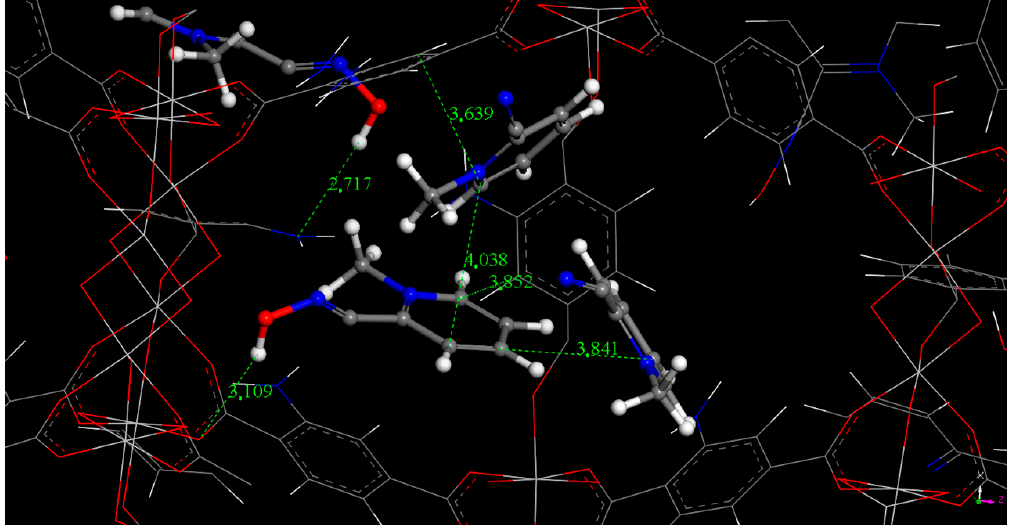
Figure 4. Main interaction sites existing between 2-PAM and MIL-125-NH 2 framework from GCMC simulations: (white atoms: H, blue atoms: N, red atoms: O, clear grey atoms: Ti, dark grey atoms: C; for the sake of clarity Cl atoms are not shown).